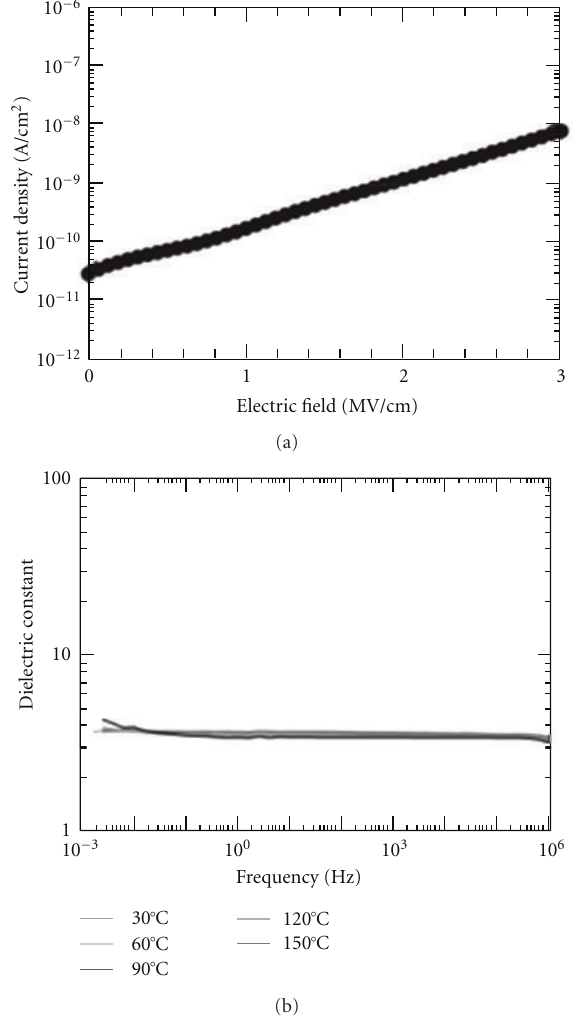
Figure 5: (a) Current density-electric field characteristics and (b) frequency dependence of dielectric constant of PMSQ film cured at 150 ◦ C for 1h in